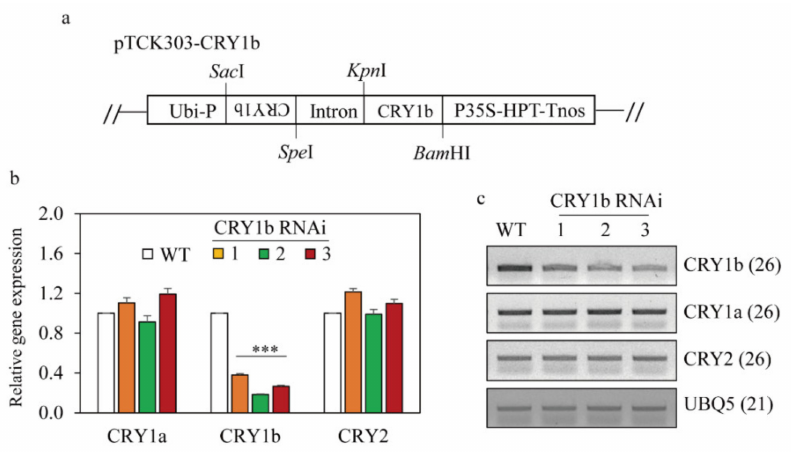
Figure 1. The structure of binary vector pTCK303 and the generation of CRY1b -suppressed transgenic rice plants. ( a ) Schematic diagram of the pTCK303:CRY1b binary vector. ( b ) Results of quantitative real-time polymerase chain reaction (PCR) analyses. ( c ) Results of reverse transcription-PCR analyses of the wild-type and transgenic (T2) lines. Rice seeds were germinated in half-strength